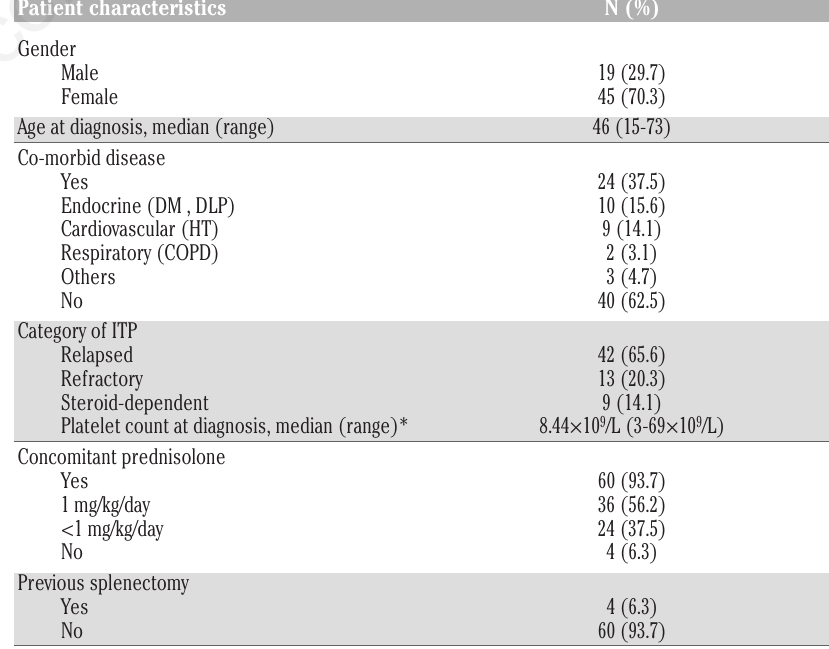
Table 1. Demographic data of relapsed, refractory and steroid-dependent immune throm- bocytopenia patients [total (n=64)]. Patient